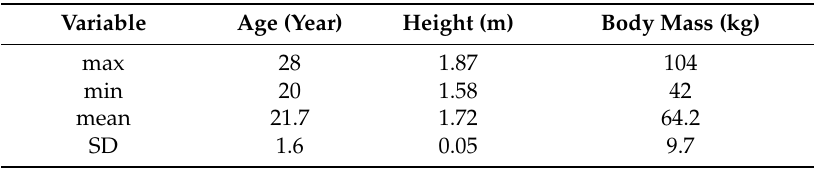
Table 1. Demographics of the participants ( n =